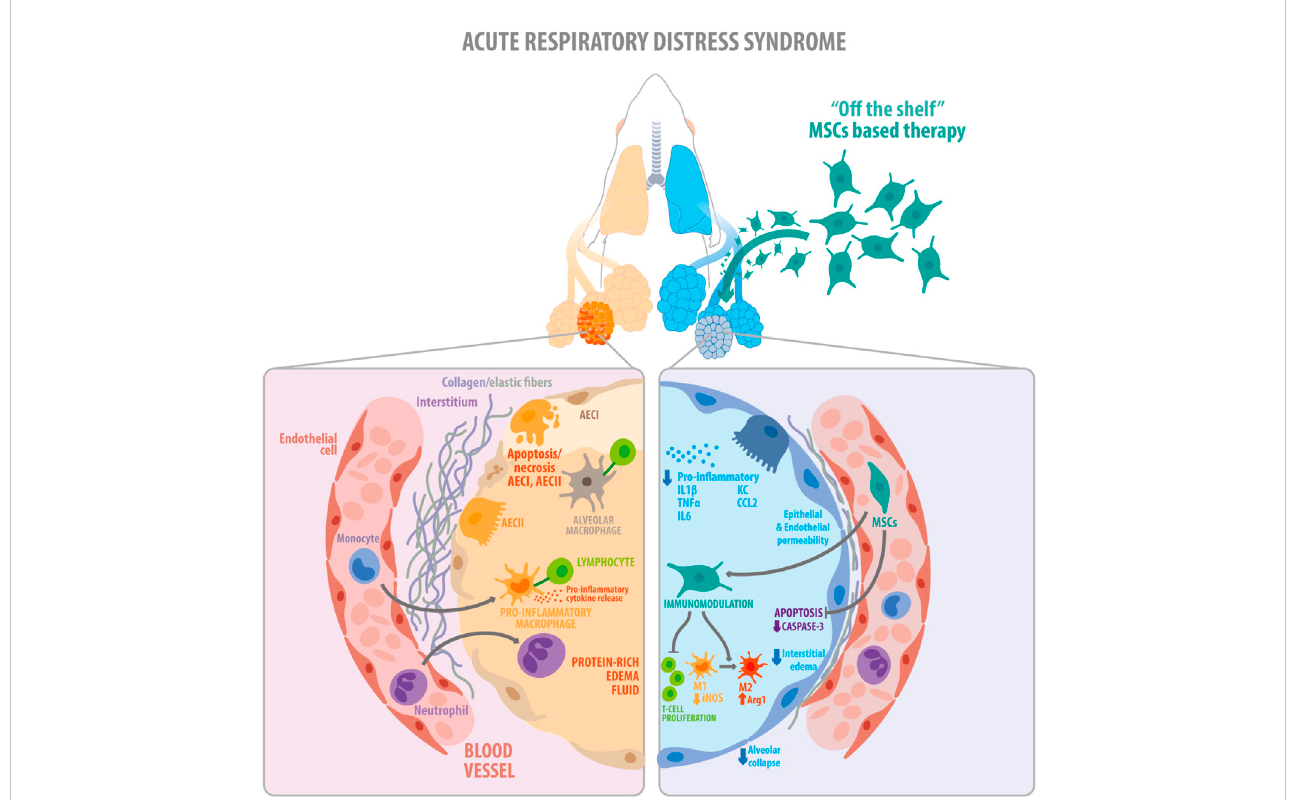
FIGURE 8 Schematic illustration showing the key fi ndings of the study. The diagram summarizes the proposed therapeutic effects exerted by the clinical-grade cryo-MenSCs in a mouse model of ARDS. On the left, the fi gure shows the alveolar, interstitial, and capillary compartments of the lung, with protein-rich oedema fl uid fi llingtheinjuredalveolus inARDS.Ontheright,cryo-MenSCsinfusedintravenouslymodulatetissuerepairthroughimmunomodulatoryeffects decreasing pro-in fl ammatory cytokines, suppression of T cell proliferation and macrophage polarization (M1 → M2). Likewise, cryo-MenSCs produced a reduced remodeling associated with a diminution in collagen and elastic fi bers and induced an increment in angiogenesis, reduction of apoptosis, alveolar collapse, and oedema (diminution of endothelium and epithelium permeability), all contribute to improving lung function impaired by ARDS. MSCs, mesenchymalstem cells;AEC(I, II),alveolarepithelial cellstypeIand typeII,IL1 β , interleukin 1beta; TNF α , tumour necrosis factoralpha; IL6, interleukin 6;KC, keratinocytes-derived chemokine; CCL2, chemokine (C-C motif) ligand 2 (also referred to as monocyte chemoattractant protein 1); M1, pro-in fl ammatory macrophage type 1; M2, anti-in fl ammatory type